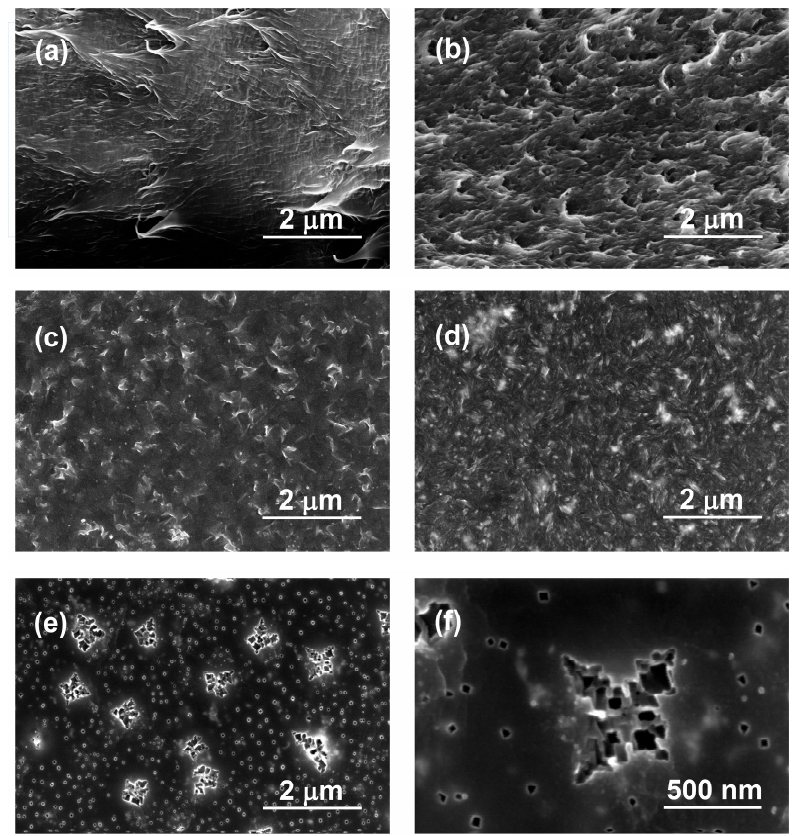
Figure 4. Scanning electron microscopy (SEM) images of pristine polyimide film R-BAPB ( a , c ) and composite film with zirconia ( b , d , e , f ). Cross-section morphology ( a , b ), images of upper side ( c , d ) and bottom side ( e , f ) of films.